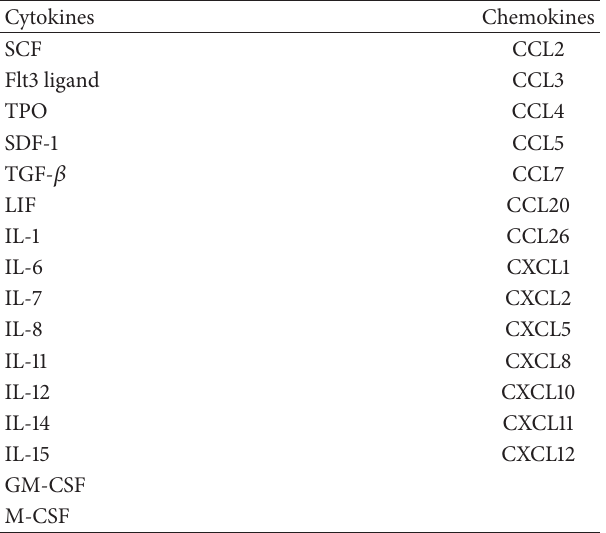
Table 1: Major cytokines and chemokines produced by BM MSCs regulating